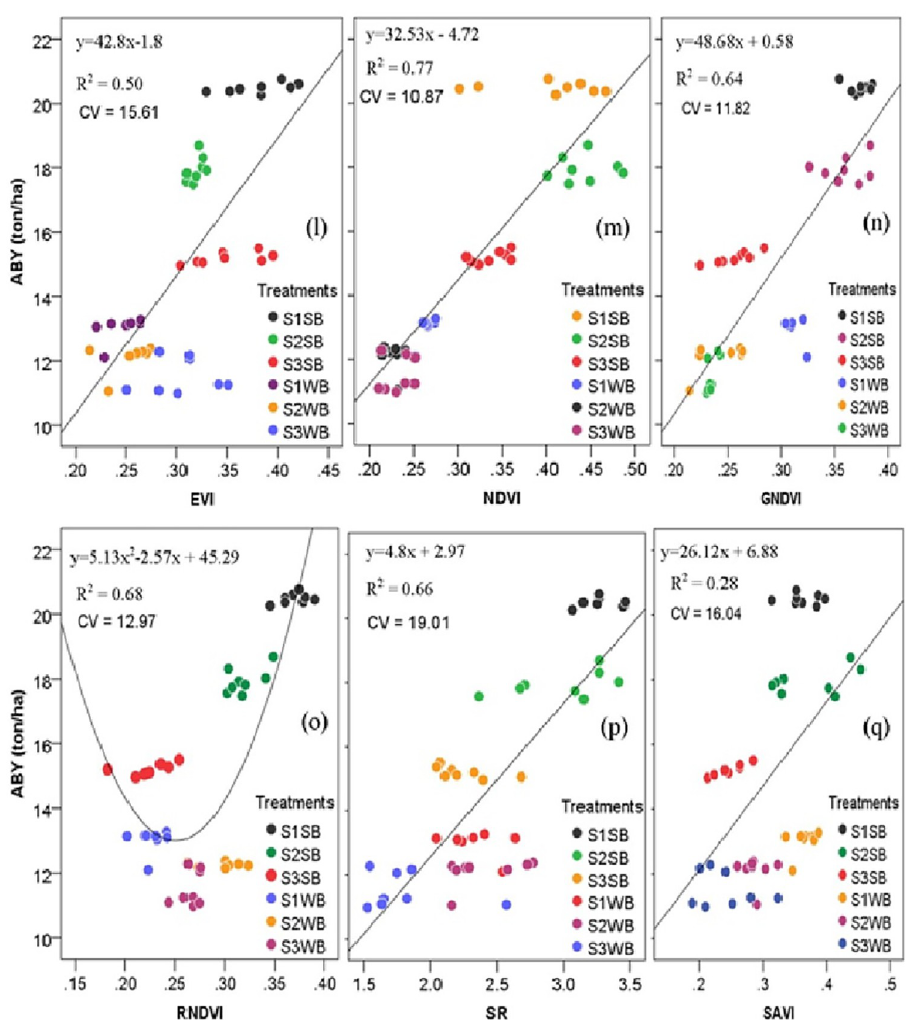
Fig 6. Scatter plots of the measured spectral vegetation indices versus predicted GY and ABY of maize: (l) EVI, (m) NDVI, (n) GNDVI, (o) RNDVI, (p) SR, and (q) SAVI (p < 0.01; the number of observations = 48). R 2 , coefficient of determination; CV, coefficient of variation; EVI, enhanced vegetation index; GNDVI, green normalized difference vegetation index; NDVI, normalized difference vegetation index; RNDVI, red normalized difference vegetation index; SR, simple ratio; SAVI, soil adjusted vegetation index; ABY, aboveground biomass yield; S1, 2–5%; S2, 5–10%; S3, 10–15%; SB, soil bund; WB: Without soil bund.